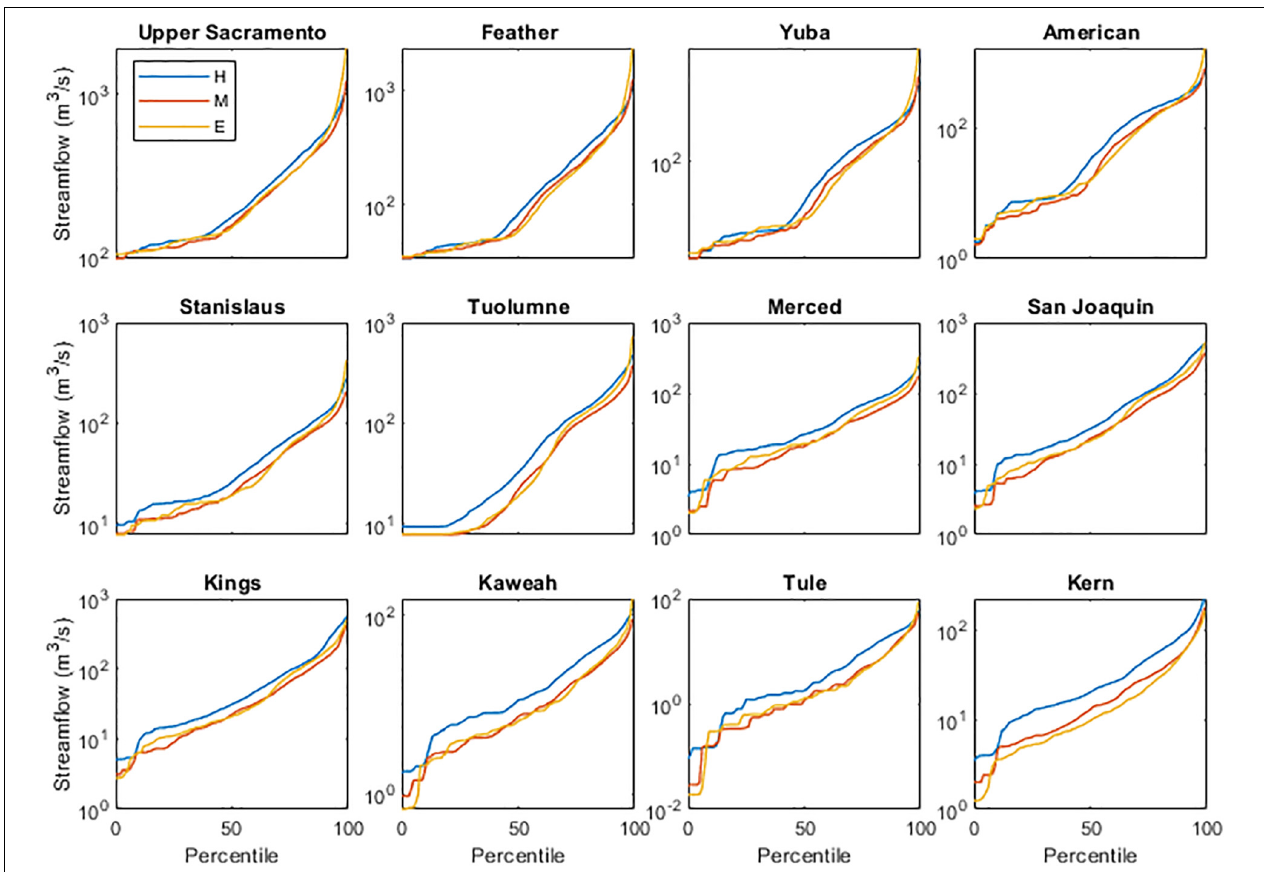
FIGURE 10 | Daily streamflow values at each percentile for 12 Sierra Nevada basins for the historic (blue), mid-century (orange), and end-century (yellow)